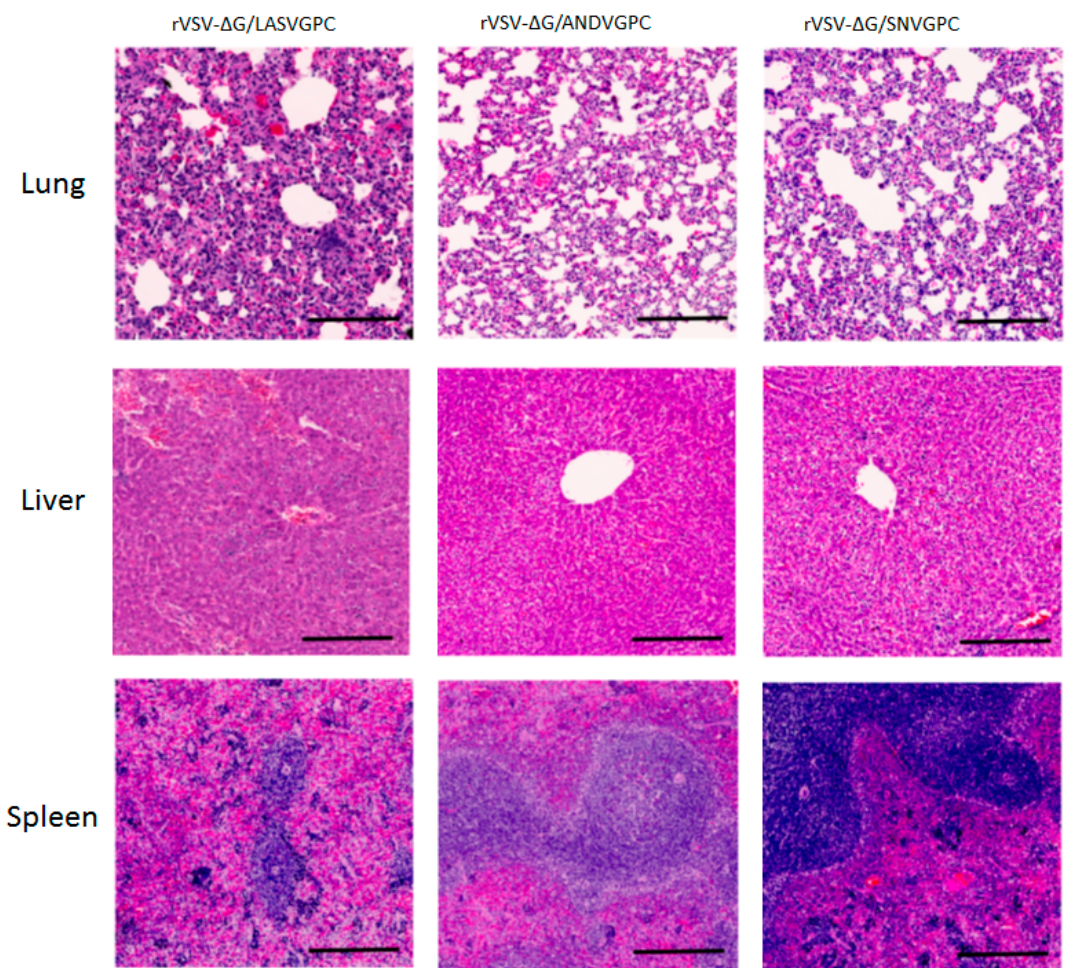
Figure 6. Histopathology of organs in vaccinated hamsters. Hematoxylin and eosin staining was performed on the lungs, livers, and spleens of hamsters on day 7 post-ANDV infection, following vaccination with either VSV ∆ G / LASVGPC, VSV ∆ G / ANDVGPC, or VSV ∆ G / SNVGPC. Scale bar = 200 µm .